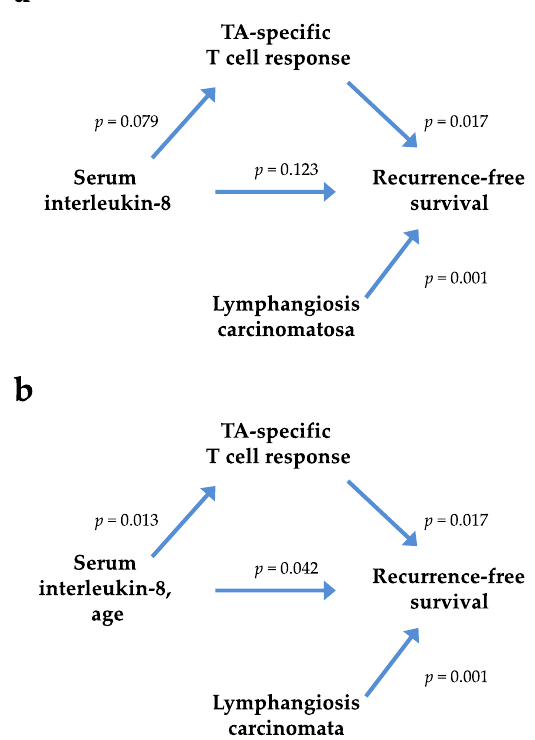
Figure 6. Associations among lymphangiosis carcinomatosa, the TA-specific T cell response, recurrence-free survival (RFS) and crude ( a ) and age-adjusted ( b ) serum IL-8